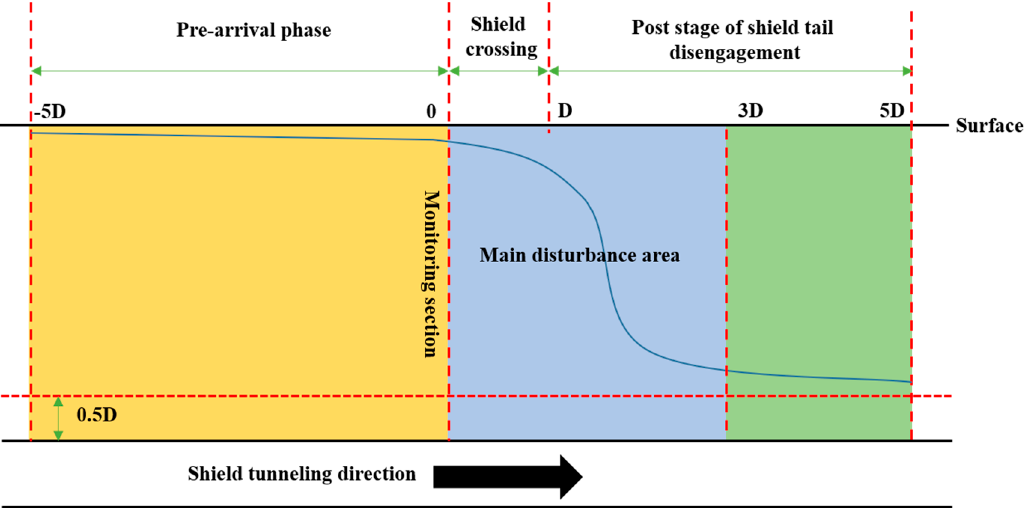
Figure 11. Vertical disturbance area division diagram.